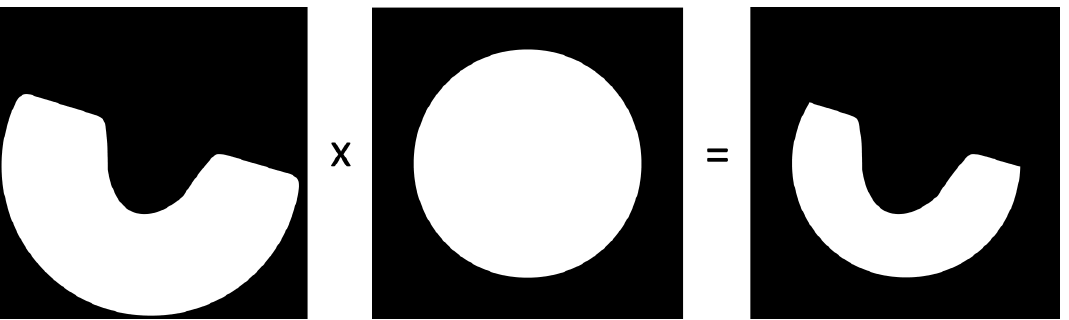
Figure 4. Obtaining the mask for the more detailed part of the orthoframe.